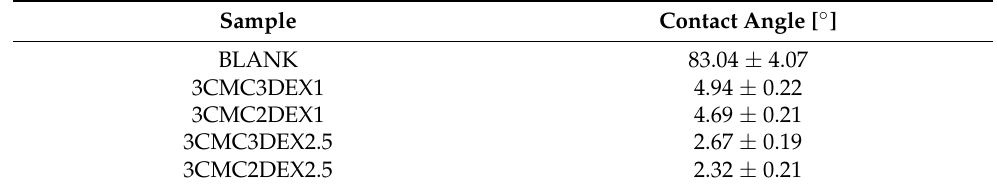
Table 1. Measured contact